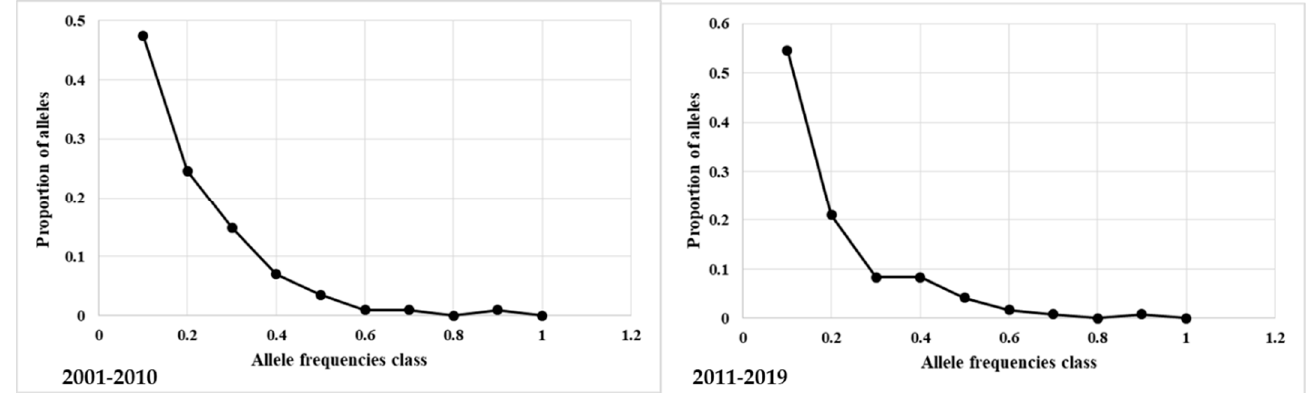
Figure 3. Expected numbers of loci with heterozygosity excess by Bottleneck software. In the plot “L” shaped distribution of allelic class vs proportion of alleles in related and unrelated LH, periods 2001–2010 and 2011–2019.